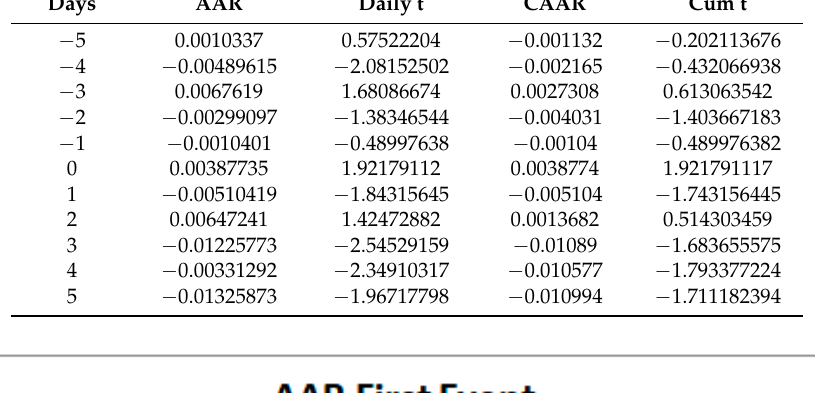
Figure 10. AAR for insurance companies. Source: Authors’ work.